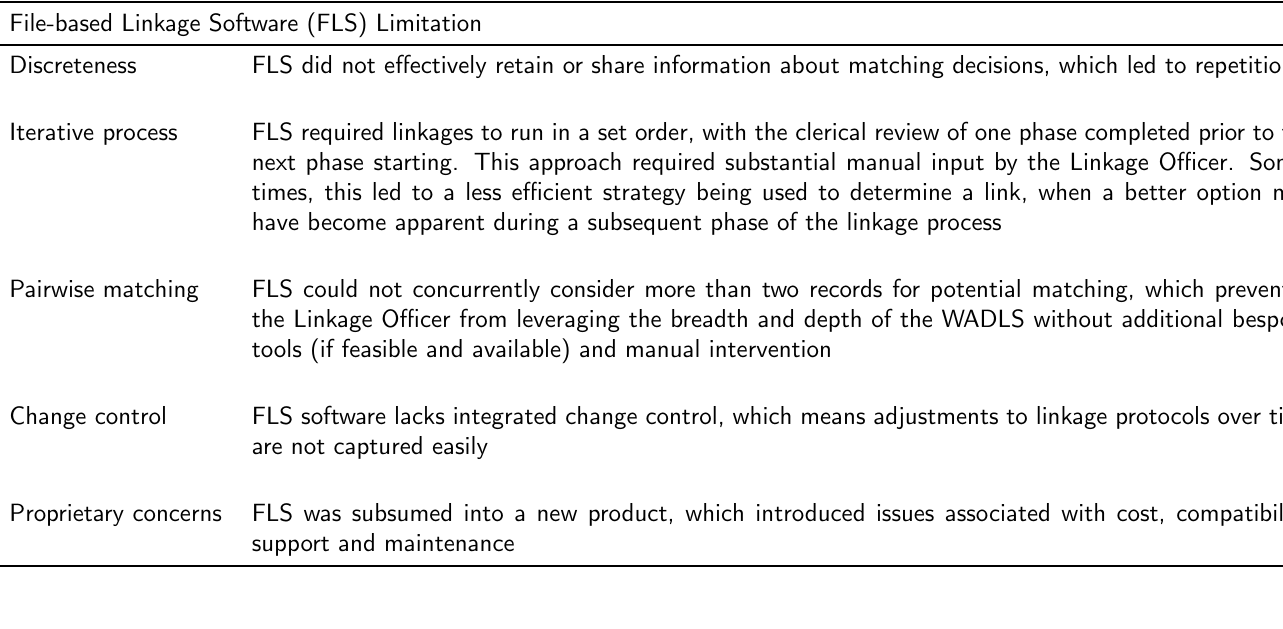
Table 1: Limitations of the File-based Linkage Software (FLS) previously used by the Data Linkage Branch